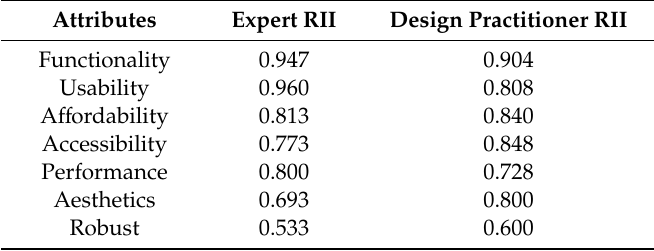
Table 5. Evaluated Relative Importance Index (RII) values of the